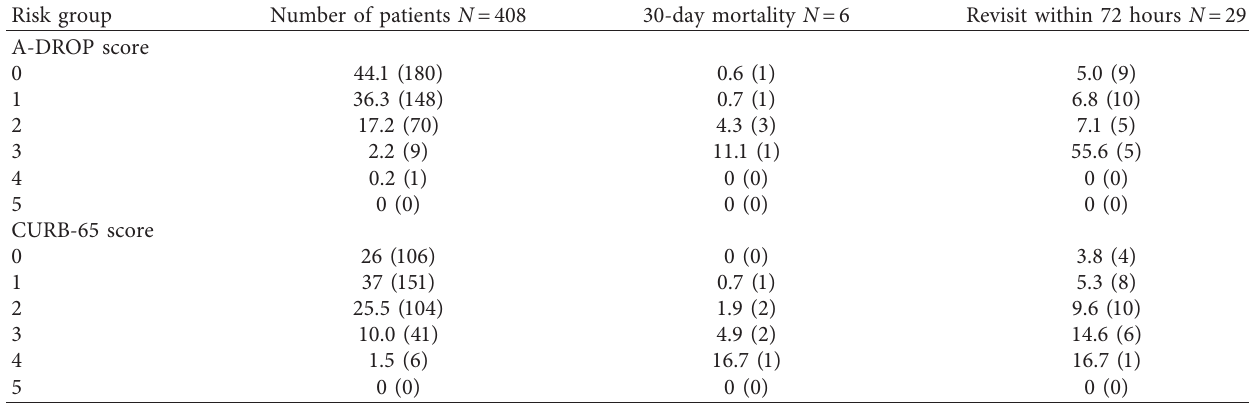
‡ The lungs are divided into five zones: right and left upper, right and left lower, and right middle zones. Abbreviations: BPM, breaths per minute; bpm, beats per minute; BUN, blood urea nitrogen; CNS, central nervous system; IQR, interquartile range; SD, standard deviation. Table 2: Distribution of patients, 30-day mortality, and hospital revisit within 72 hours in each risk class assessed using the A-DROP and CURB-65 scoring